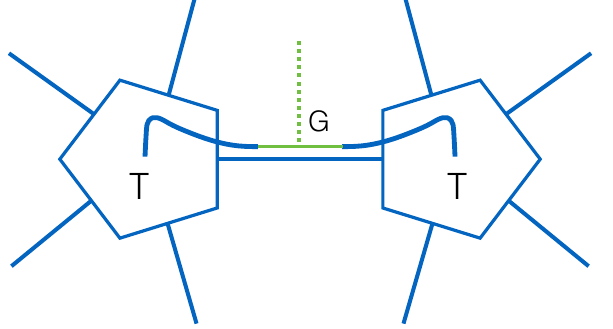
Figure 3. Our code is built from 6 copies of the code from [2] by contracting the tensor G with a pair of neighboring bulk inputs. The relevant two T -tenors are shown here, where we have chosen them both to be part of the same copy of the pentagon